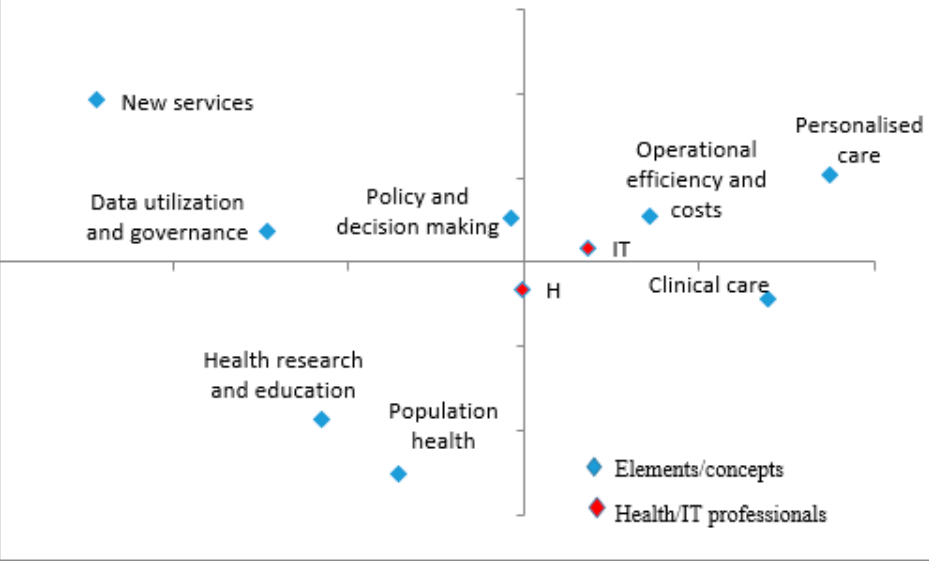
Figure 4. Benefits of Big Data.